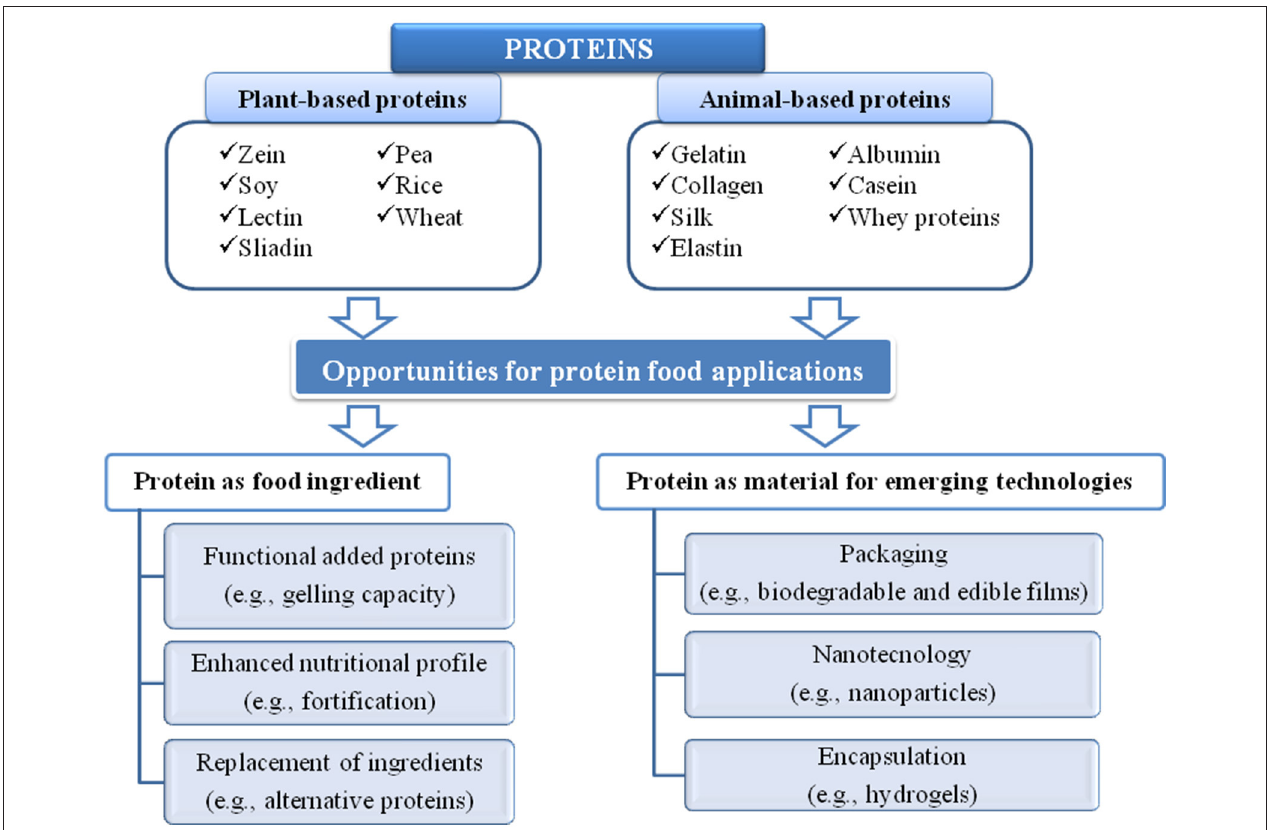
FIGURE 1 | Main plant and animal proteins used in food industry and some of their food